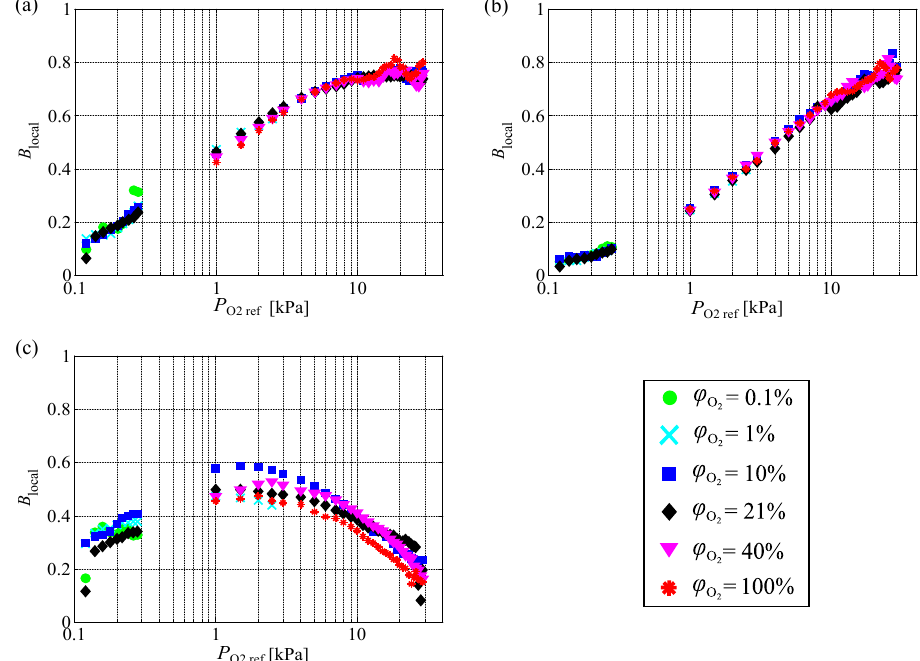
Figure 7. Effect of partial pressure of oxygen on B local at various oxygen mole fractions for ( a ) PHFIPM-PSP, ( b ) PC-PSP, and ( c )